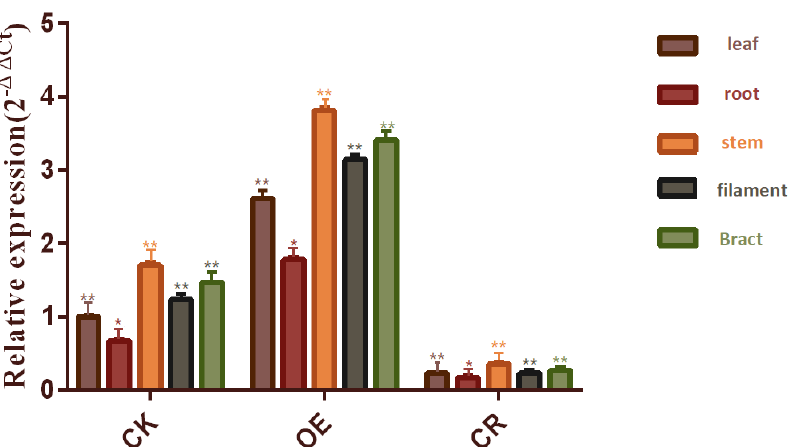
Figure 1. Relative expression of the ZmBON3 gene in T2 generation recombination plants. Leaves, roots, and stems were taken from the three-leaf stage plants, while filaments and bracts were taken from the mature stage plants. The expression data of the same parts of CK, OE, and CR plants were selected for statistical analysis. CK: control plants; OE: transgenic plants overexpressing the ZmBON3 gene; CR: ZmBON3 -gene-edited plants. Each set of data was taken from the mean value of relative expression and statistically analyzed. Similar results were obtained in three separate experiments. The relative expression levels with significant differences were marked with * (* p ≤ 0.05, ** p ≤ 0.01).